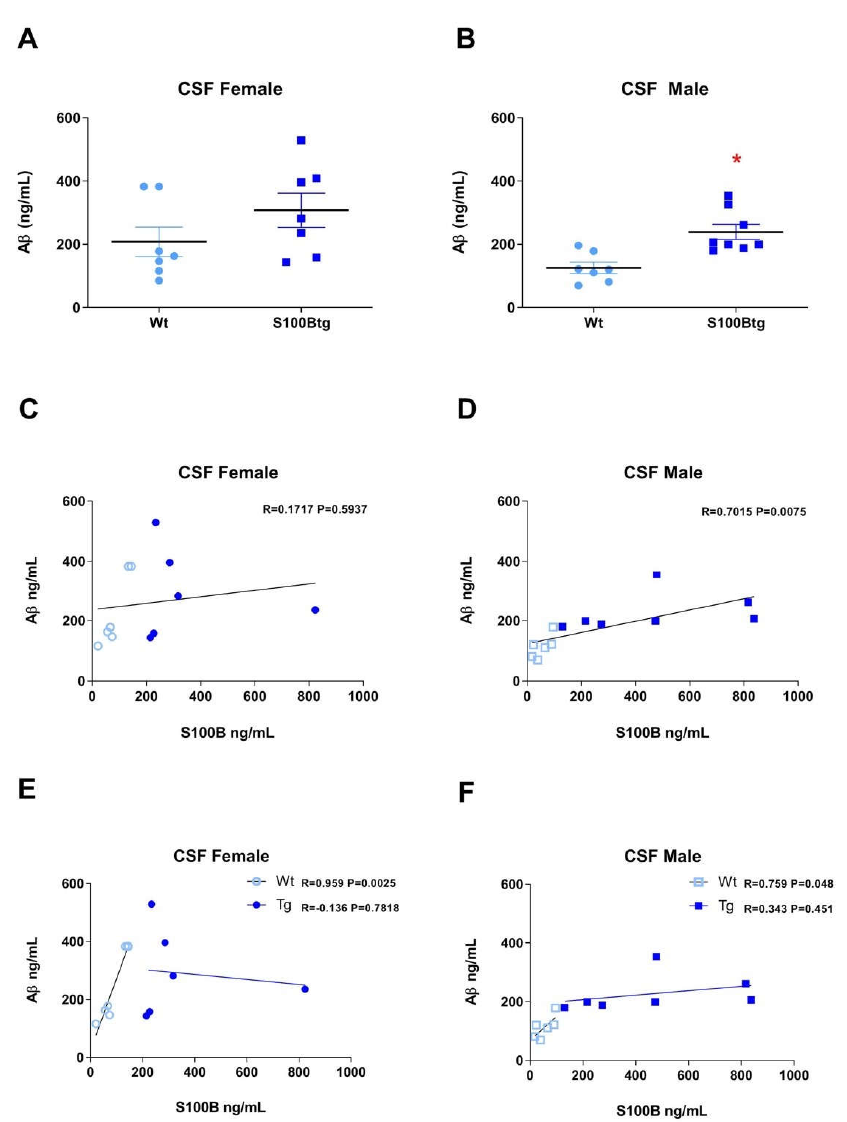
Figure 5. CSF levels of amyloid β -peptide 1-42 (A β 42 ) and correlation of S100B and amyloid β 42 in one-year-old S100Btg and wt mice. A β 42 levels were quantified in ( A , B ) the cerebrospinal fluid (CSF), * indicates a statistically significant difference (Student’s t -test, assuming p < 0.05); ( C – F ) we determined correlations between S100B CSF and A β 42 CSF in wt and S100Btg mice, as analyzed by the Pearson correlation coefficient, assuming p <